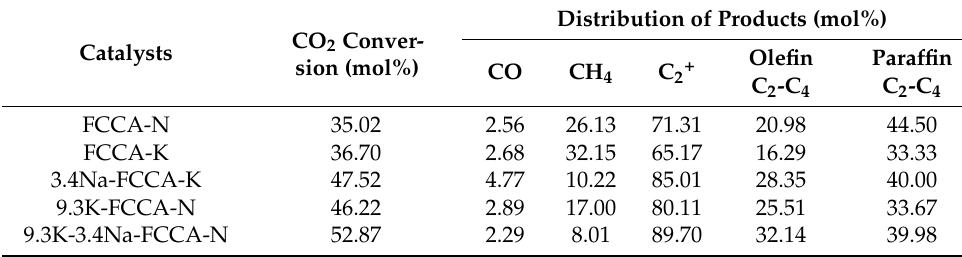
Table 2. Catalytic properties of K- and/or Na-promoted FCCA-N in CO 2